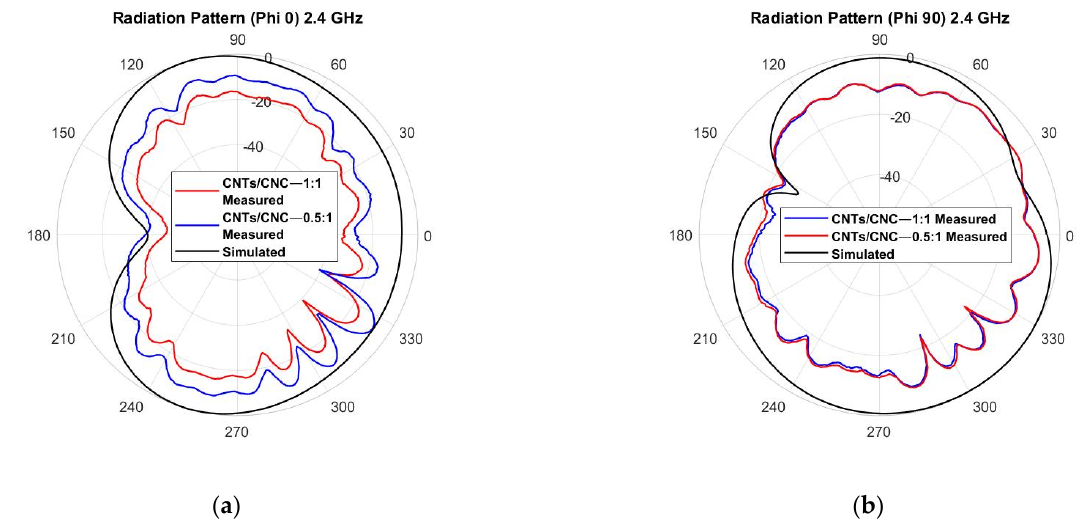
Figure 19. Measured vs. simulated radiation pattern of the graphene-based textile LOOP antenna on the phantom, E -plane cut at φ = 90° and H -plane cut at φ = 0°.